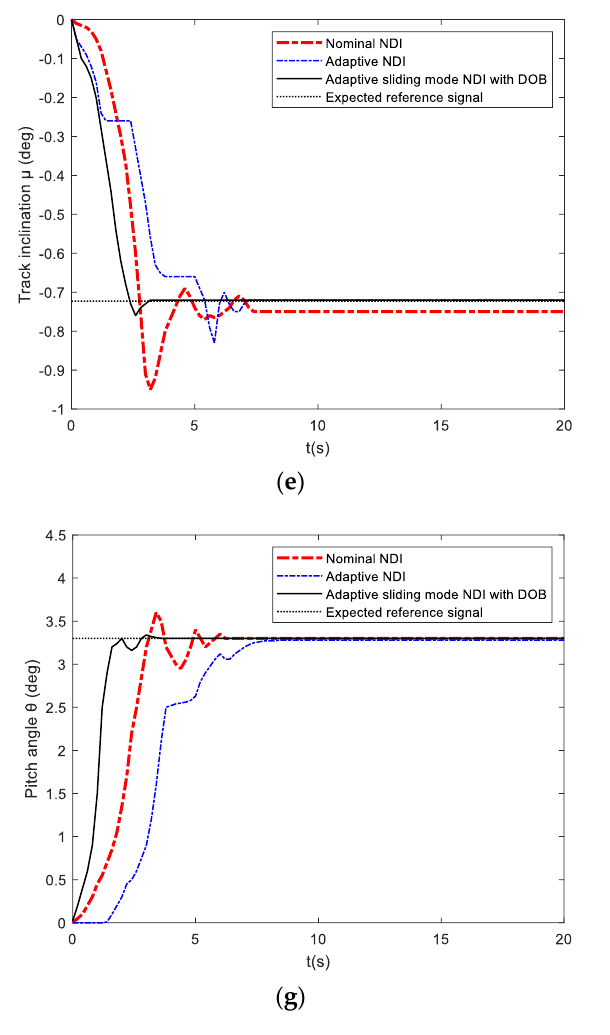
Figure 7. Comparison of the effects of different HFV controllers under inertia uncertainty and disturbance. ( a ) Tracking curves of the normal overload Nys . ( b ) Tracking curves of pitch rate derivative q . ( c ) Tracking curves of the pitch derivative θ . ( d ) Tracking curves of the attack angle derivative α . ( e ) Tracking curves of the track inclination µ . ( f ) Tracking curves of the attack angle α . ( g ) Tracking curves of the pitch angle θ . Table 3. Comparative analysis I of performance indicators between proposed